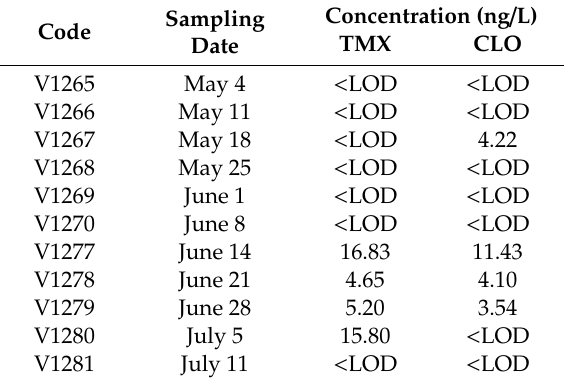
Table 2. Concentration of neonicotinoids (ng / L) determined in Danube River at Budapest, Hungary in 2017.